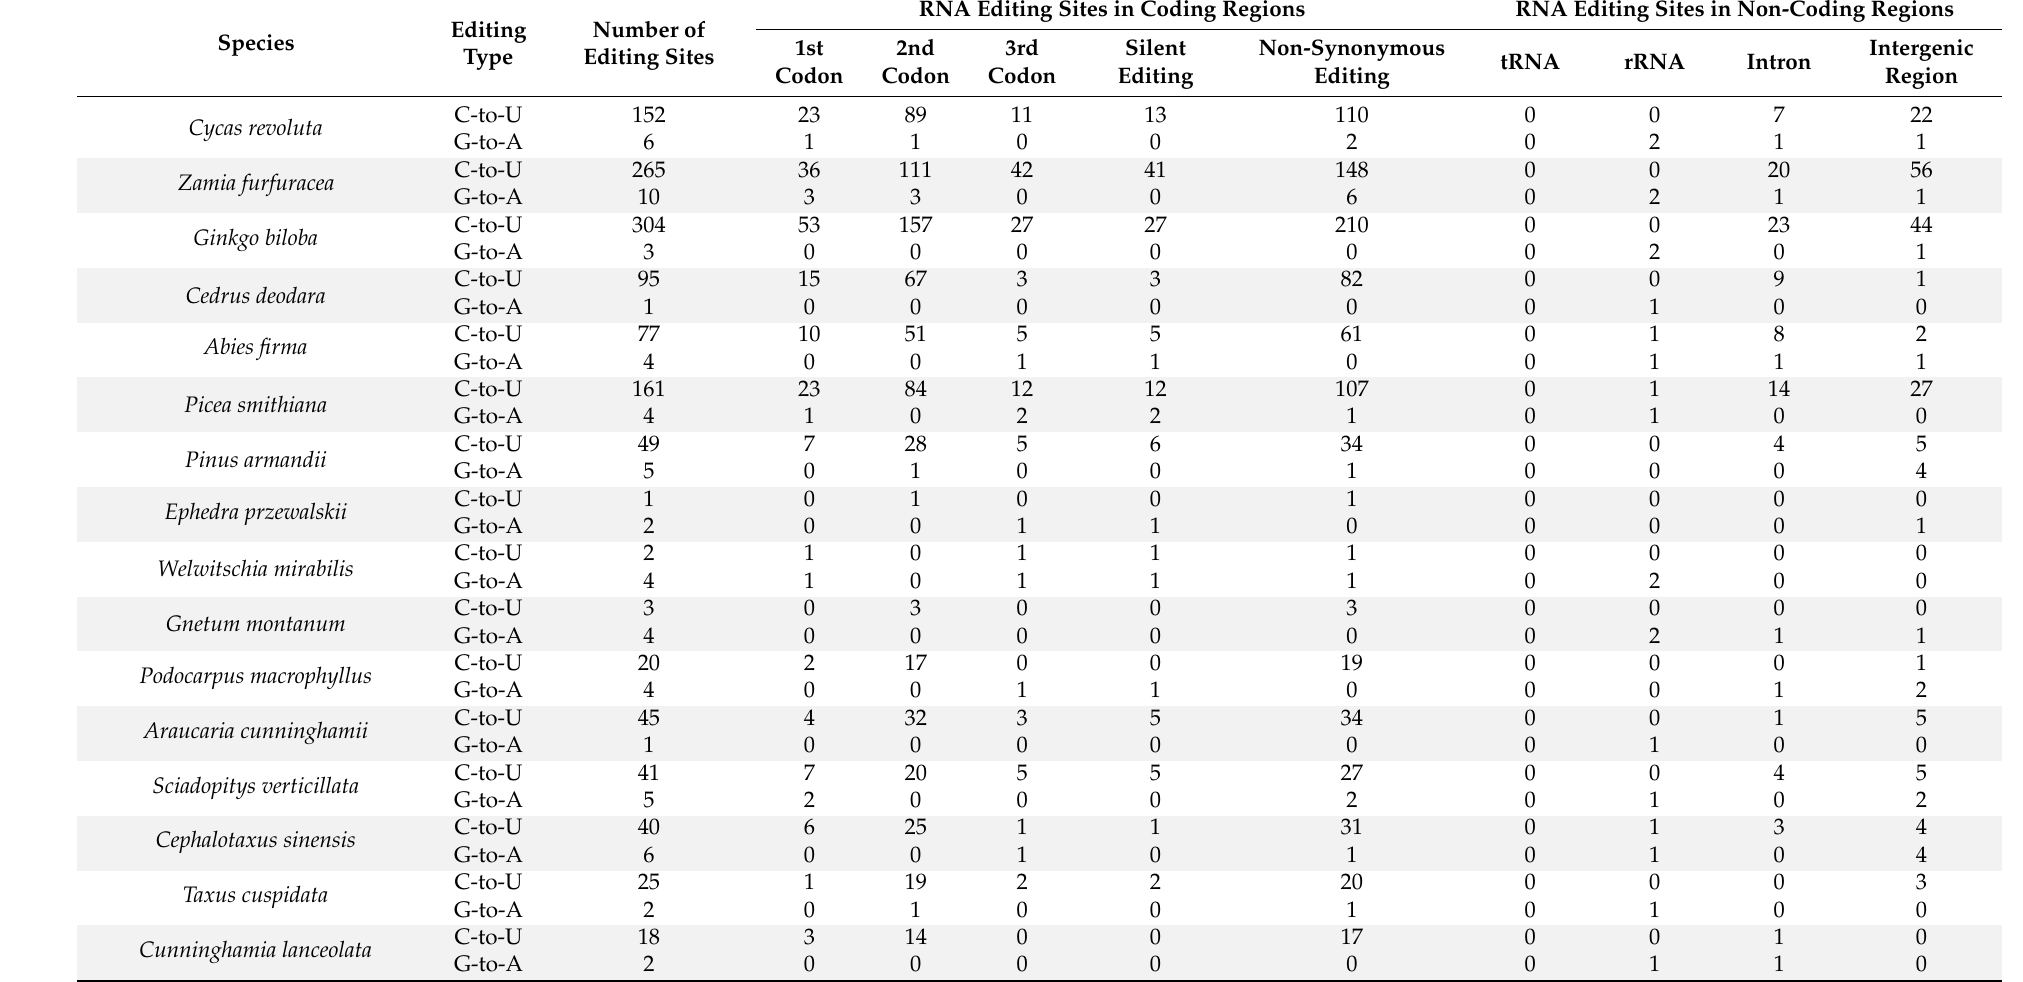
Table 1. Summary of chloroplast RNA editing sites in